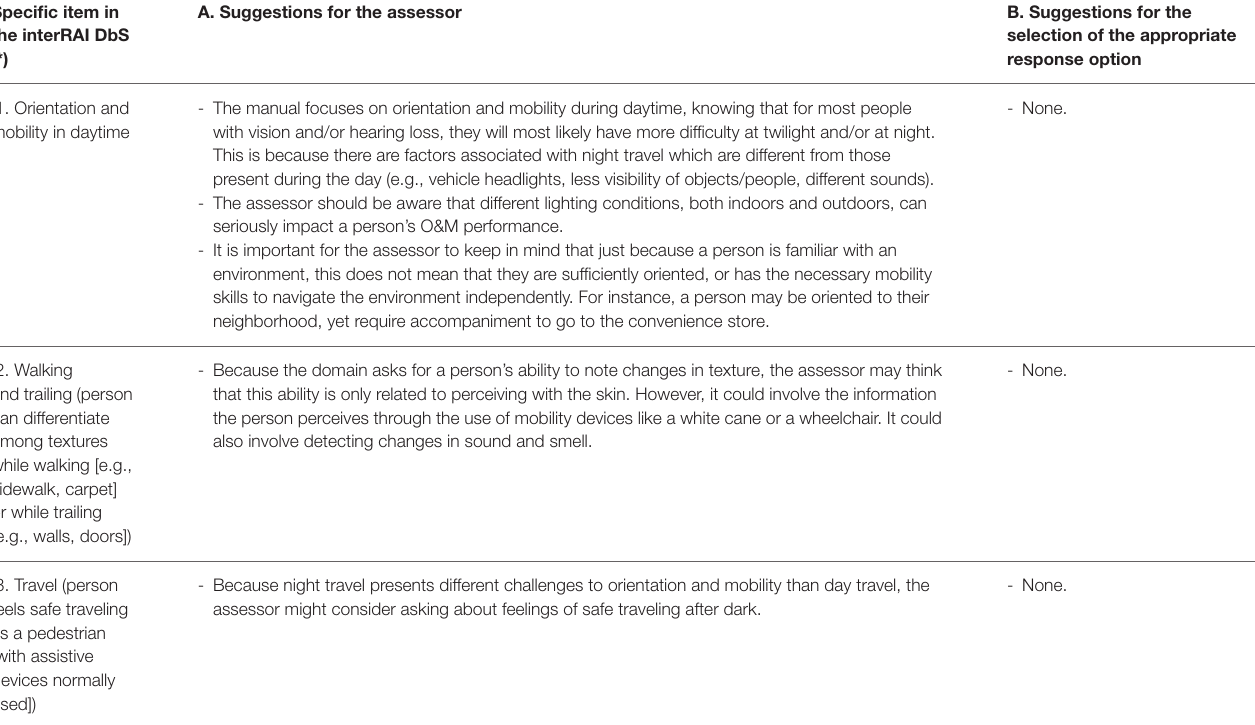
TABLE 5 | Supplemental guidelines for completing interRAI DbS section I Orientation and Mobility (O&M). Specific item in the interRAI